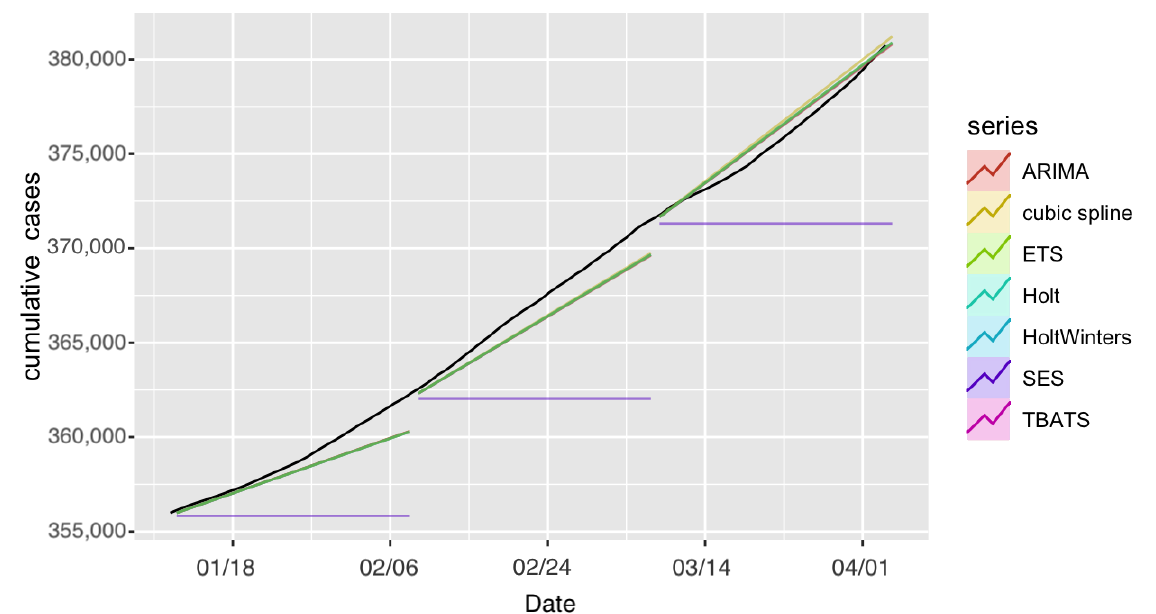
Figure 4. Forecast recoveries in Saudi Arabia projected under each model and forecasting period. Black line represents observed recoveries. Table 4. Performance of proposed models to predict KSA recoveries. The best accuracy values are shown in bold. Period 1 Period